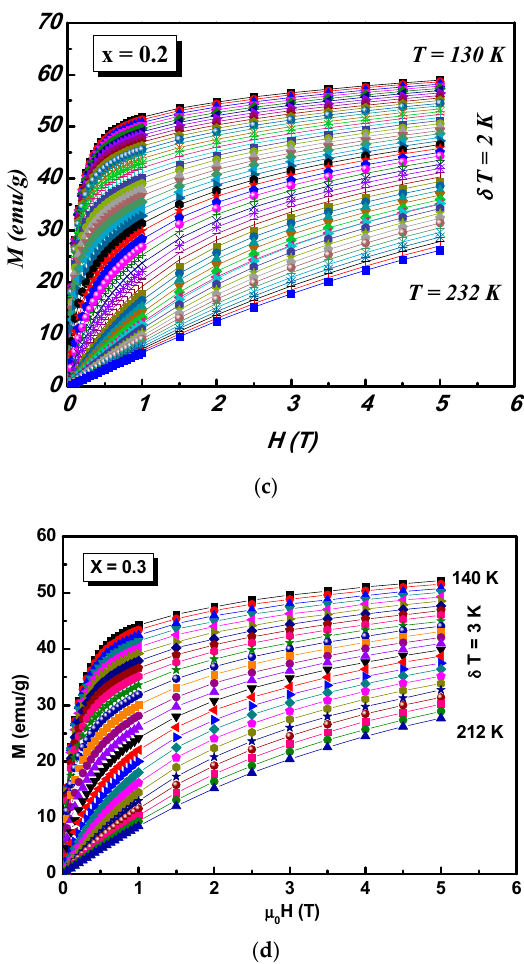
Figure 3. Magnetization vs. applied magnetic field µ 0 H measured at different temperatures for: ( a ) La 0.8 Ca 0.2 MnO 3 ; ( b ) La 0.8 Ca 0.2 Mn 0.9 Co 0.1 O 3 ; ( c ) La 0.8 Ca 0.2 Mn 0.8 Co 0.2 O 3 ; and ( d ) La 0.8 Ca 0.2 Mn 0.7 Co 0.3 O 3 .